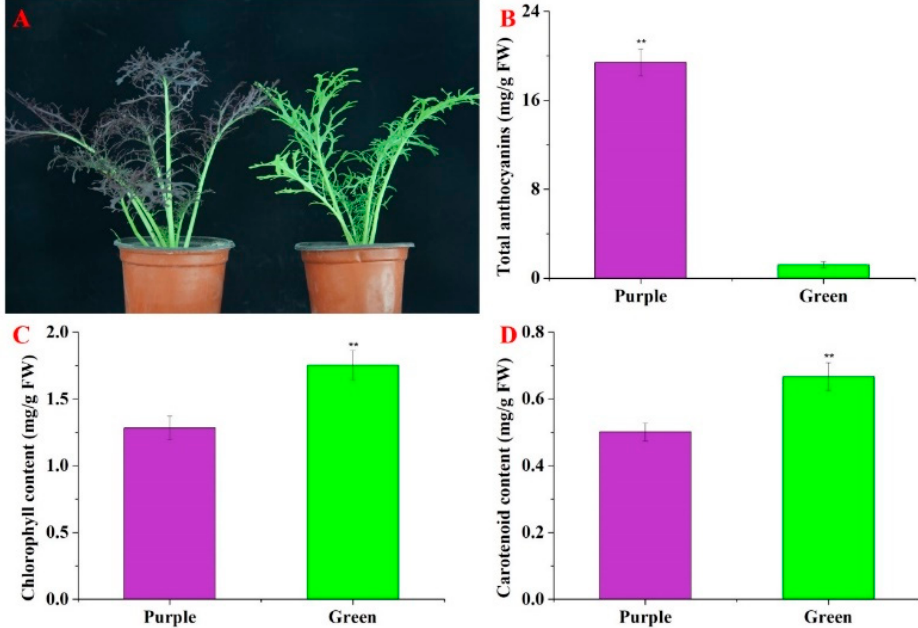
Figure 1. Phenotypes and anthocyanin content of the purple non-heading Chinese cabbage and its green mutant. ( A ) Phenotypes of purple non-heading Chinese cabbage and its green mutant. Bar = 1 cm. ( B ) The anthocyanin content in leaves of purple non-heading Chinese cabbage and its green mutant. ( C ) Chlorophyll content in the leaves of purple non-heading Chinese cabbage and its green mutant. ( D ) Carotenoid content in the leaves of purple non-heading Chinese cabbage and its green mutant. Error bars show standard errors (SE). ** indicates significant differences at p ≤